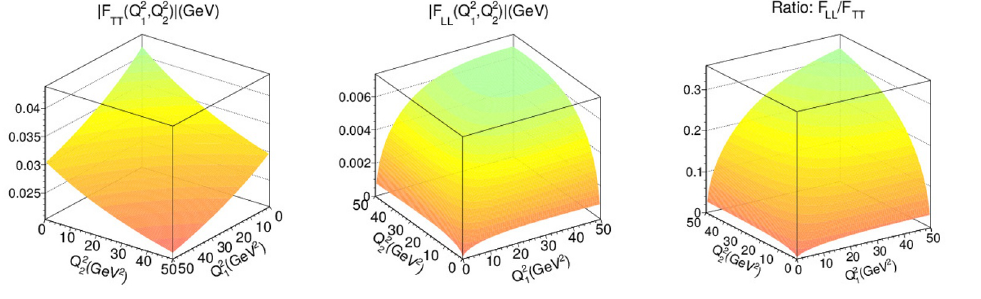
Figure 4 . j F TT j (left) and F LL (right) form factors for the Buchm(cid:127)uller-Tye potential for (cid:31) b 0 .